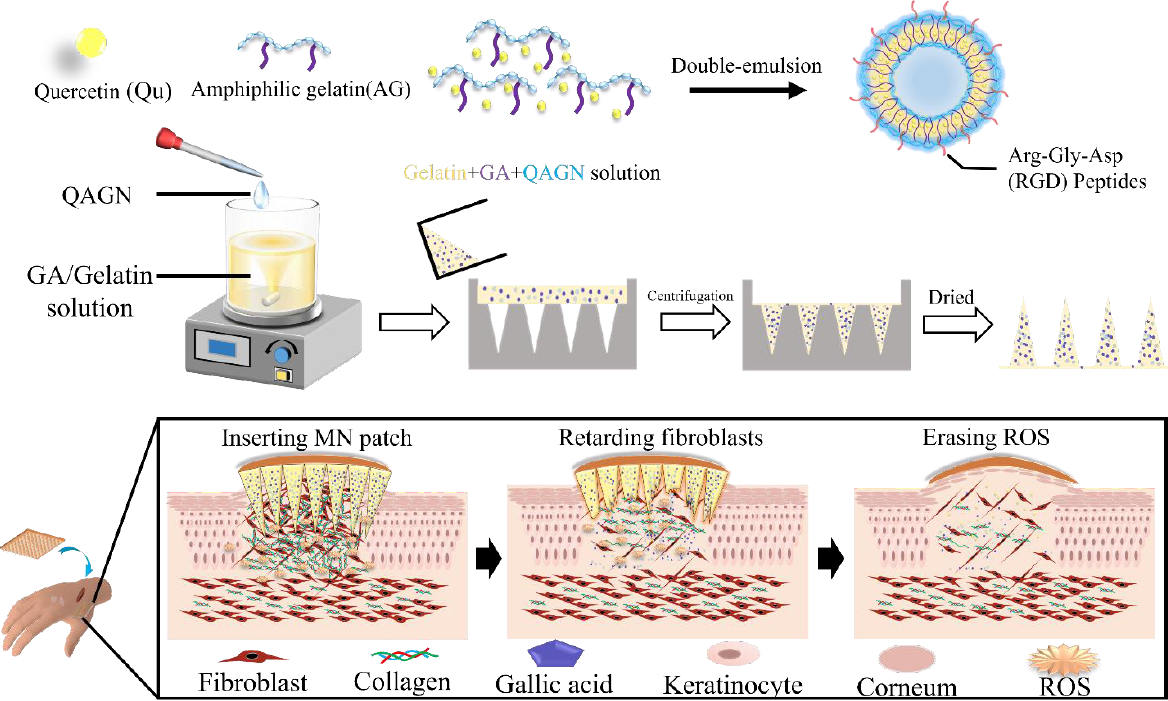
Figure 1. Schematic illustration of the preparation of the quercetin (Qu)-loaded amphiphilic gelatin nanocarrier and process of drug release. The prevention of keloid scars by controlling transdermal dual-drug release of Qu and GA via modulating heterogeneous gelatin-structured composite microneedles.